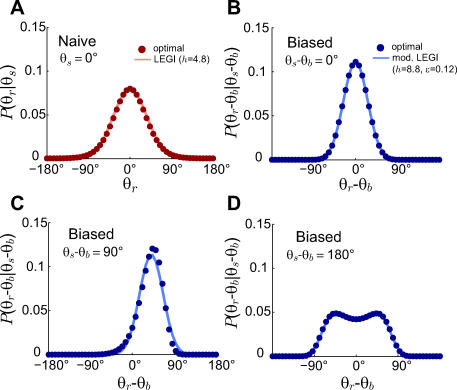
Comparison of Modified LEGI Model to the Optimal Response Distribution(A) Probability distribution of the response to a gradient angle of θs = 0 that optimally achieves the rate distortion curve with D = 0.1 for Θs uniformly distributed (dark red circles). Also shown is the response to θs = 0 of the LEGI model with h = 4.8 (light red line).(B–D) Probability distribution of the optimal response for D = 0.1 to a normally distributed input with variance 45° and an observed gradient angle that differs from the mean (bias) by 0°, 90°, and 180° (dark blue circles in (B), (C), and (D), respectively). Also shown is the response of the modified LEGI model with ɛ = 0.12 and h = 8.8 (light blue lines).In all panels (A–D), binding is excluded from the computations of the model response (i.e., Yi = L(θi)) so as to more accurately compare Hill coefficients to experimental observations. Inclusion of binding also yields good fits to the optimal response, only with slightly larger Hill coefficients.